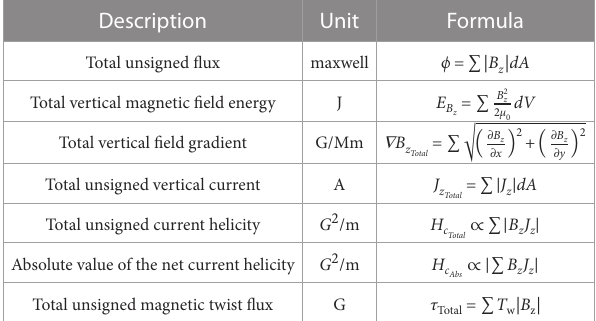
TABLE2 Theseveninvestigatedmagneticfieldparameterswithassociated